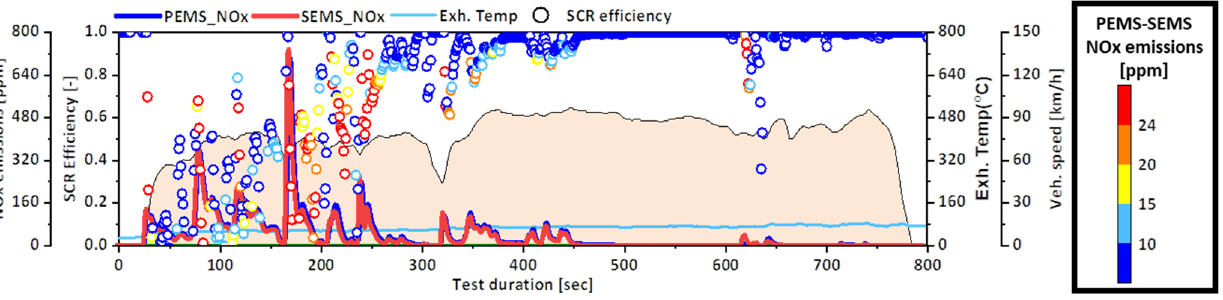
Figure 12. Real-time profiles of CO emissions and the difference between NOx emissions measured by the PEMS and SEMS equipment under US06 test modes in the laboratory.